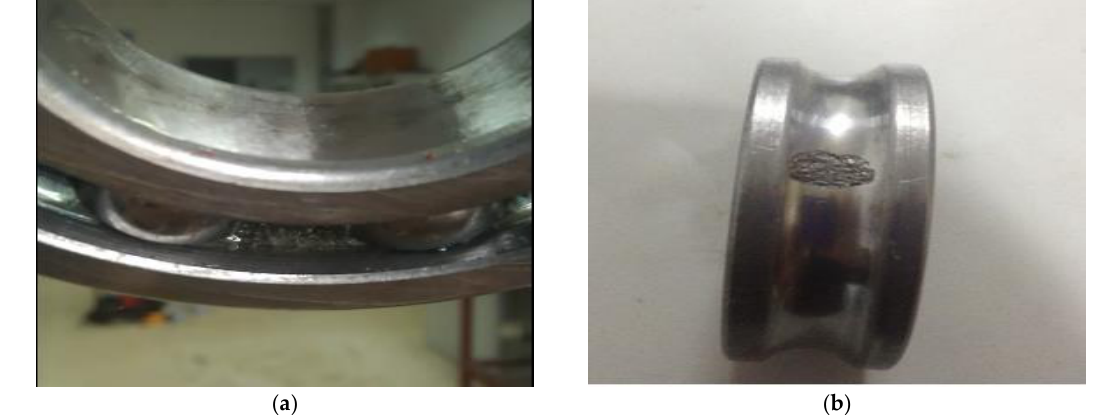
Figure 4. The defective surface of failure bearings: ( a ) outer-race fault, ( b ) inner-race fault.